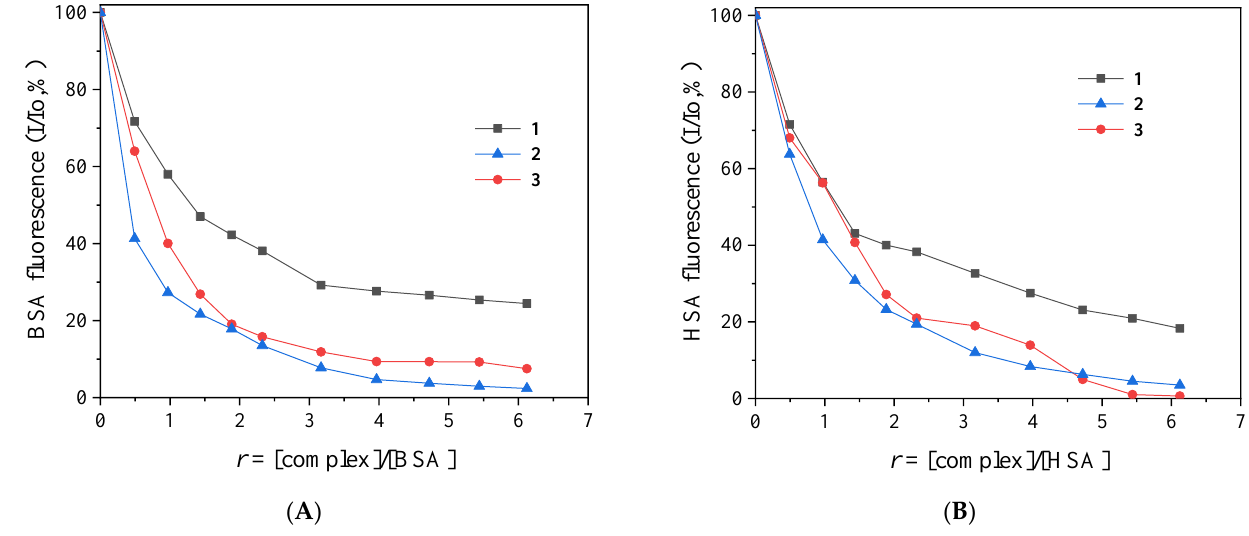
Figure 7. ( A ) Plot of % relative BSA fluorescence emission intensity (I/Io, %) at λ em,max = 343 nm versus r (= [complex]/[BSA]) for complexes 1 – 3 (up to 24.4% of the initial BSA fluorescence for 1 , 7.5% for 2 , and 2.4% for 3 ). ( B ) Plot of % relative HSA fluorescence emission intensity (I/Io %) at λ em,max = 351 nm versus r (=[complex]/[HSA]) for complexes 1 – 3 (up to 18.3% of the initial HSA fluorescence for 1 , 0.6% for 2 , and 3.5% for 3 ). Table 7. The albumin-quenching constants (K q ) and albumin-binding constants (K) for complexes 1 – 3 .